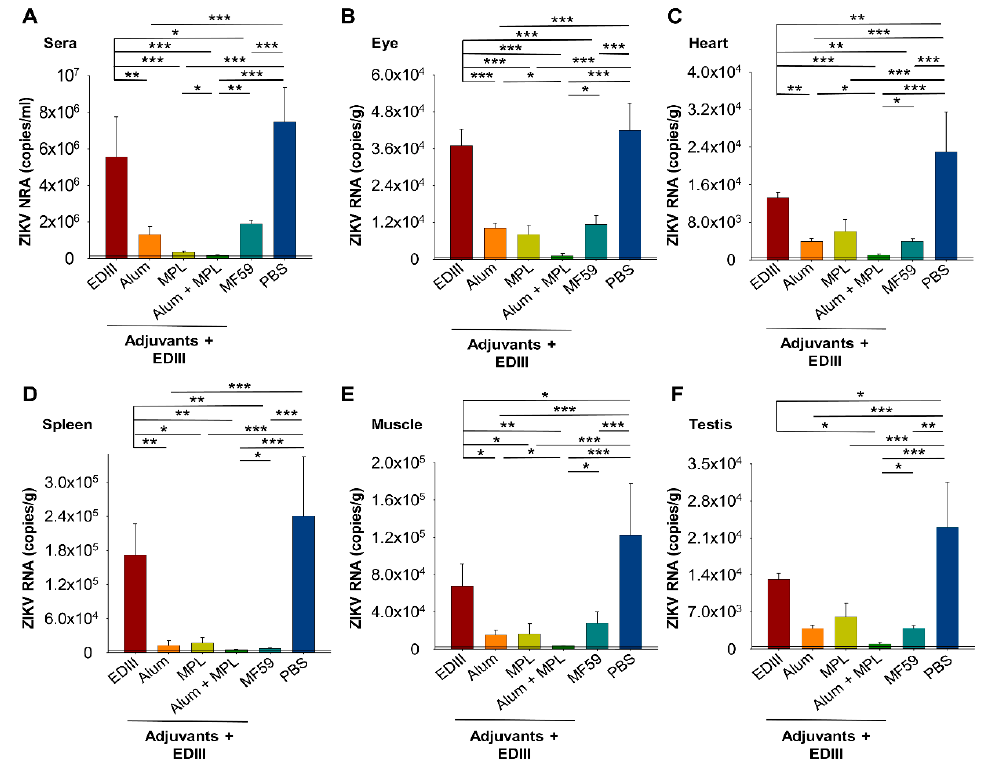
Figure 6. Detection of ZIKV RNA in challenged sera ( A ), eye ( B ), heart ( C ), spleen ( D ), muscle ( E ), and testis ( F ). Sera and tissues were collected at three days post-challenge with ZIKV (strain R103451) and viral RNA copies determined by qRT-PCR. Mice immunized with PBS served as the control. The detection limits were ~10 3 RNA copies/mL (sera), ~5 × 10 2 RNA copies/g (eye, heart, and spleen), and ~2.5 × 10 2 RNA copies/g (muscle and testis). Data are expressed as the mean ± s.e.m ( n = 5). Significant differences (*: p < 0.05; **: p < 0.01; ***: p < 0.001) among different groups are shown.